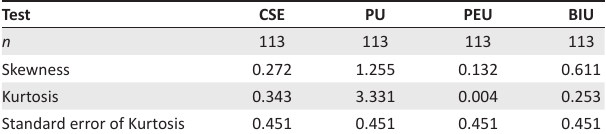
TABLE 4: Tests of